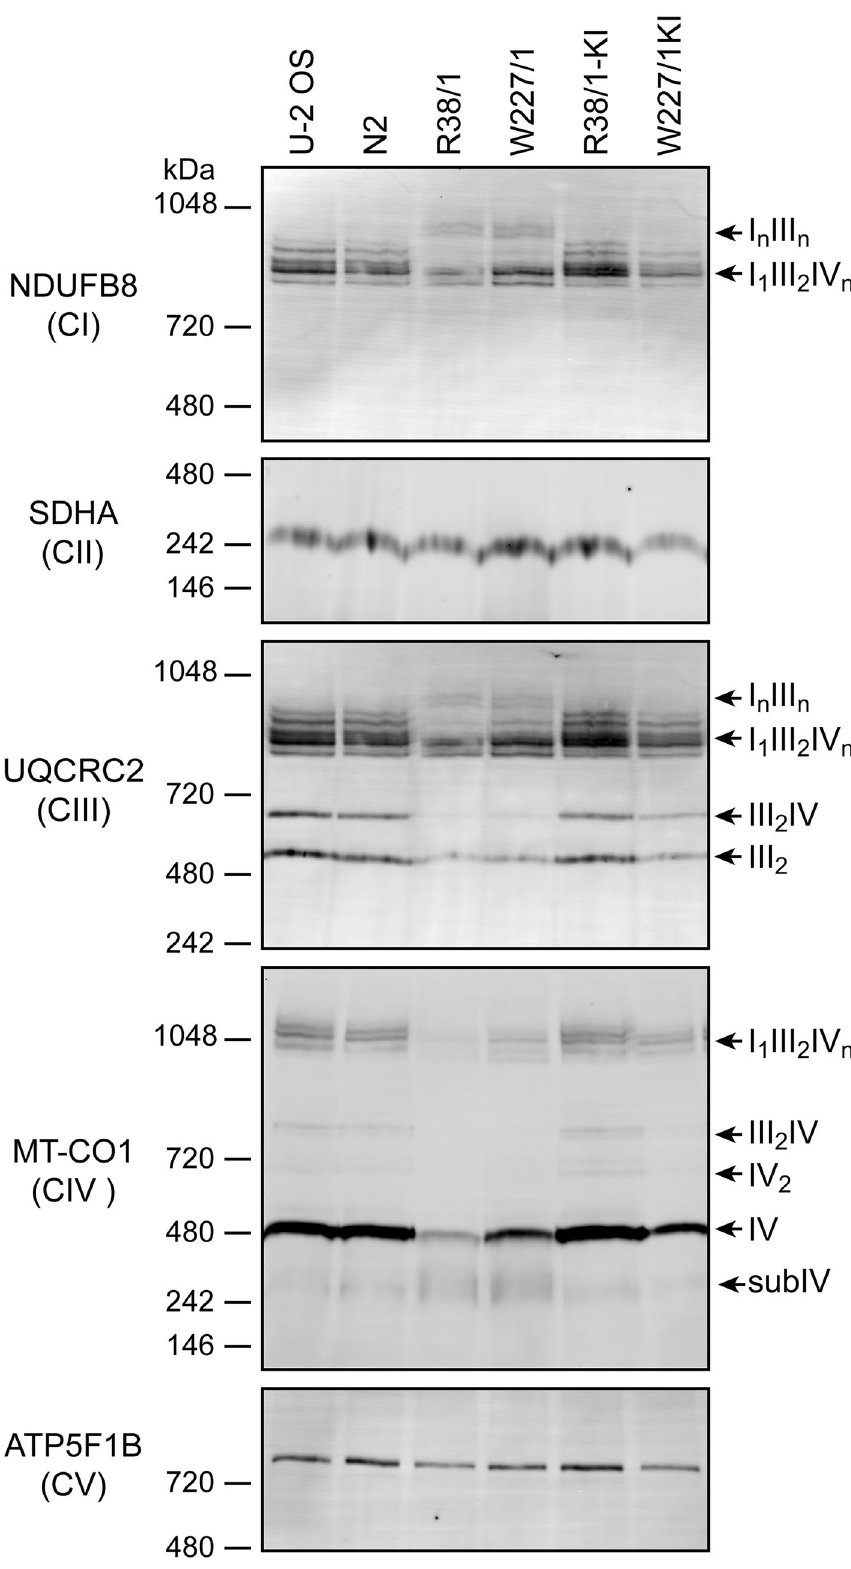
Figure 4. Analysis of OXPHOS (super)complexes. Protein complexes were extracted from cells by digitonin treatment and 20 µg of total proteins from each sample were separated by BN-PAGE and electroblotted onto a PVDF membrane. Antibodies specific for NDUFB8, SDHA, UQCRC2, MT-CO1 and ATP5F1B were used for detection of the complex CI, CII, CIII, CIV and CV, respectively. Signals of CII and CV were considered as loading